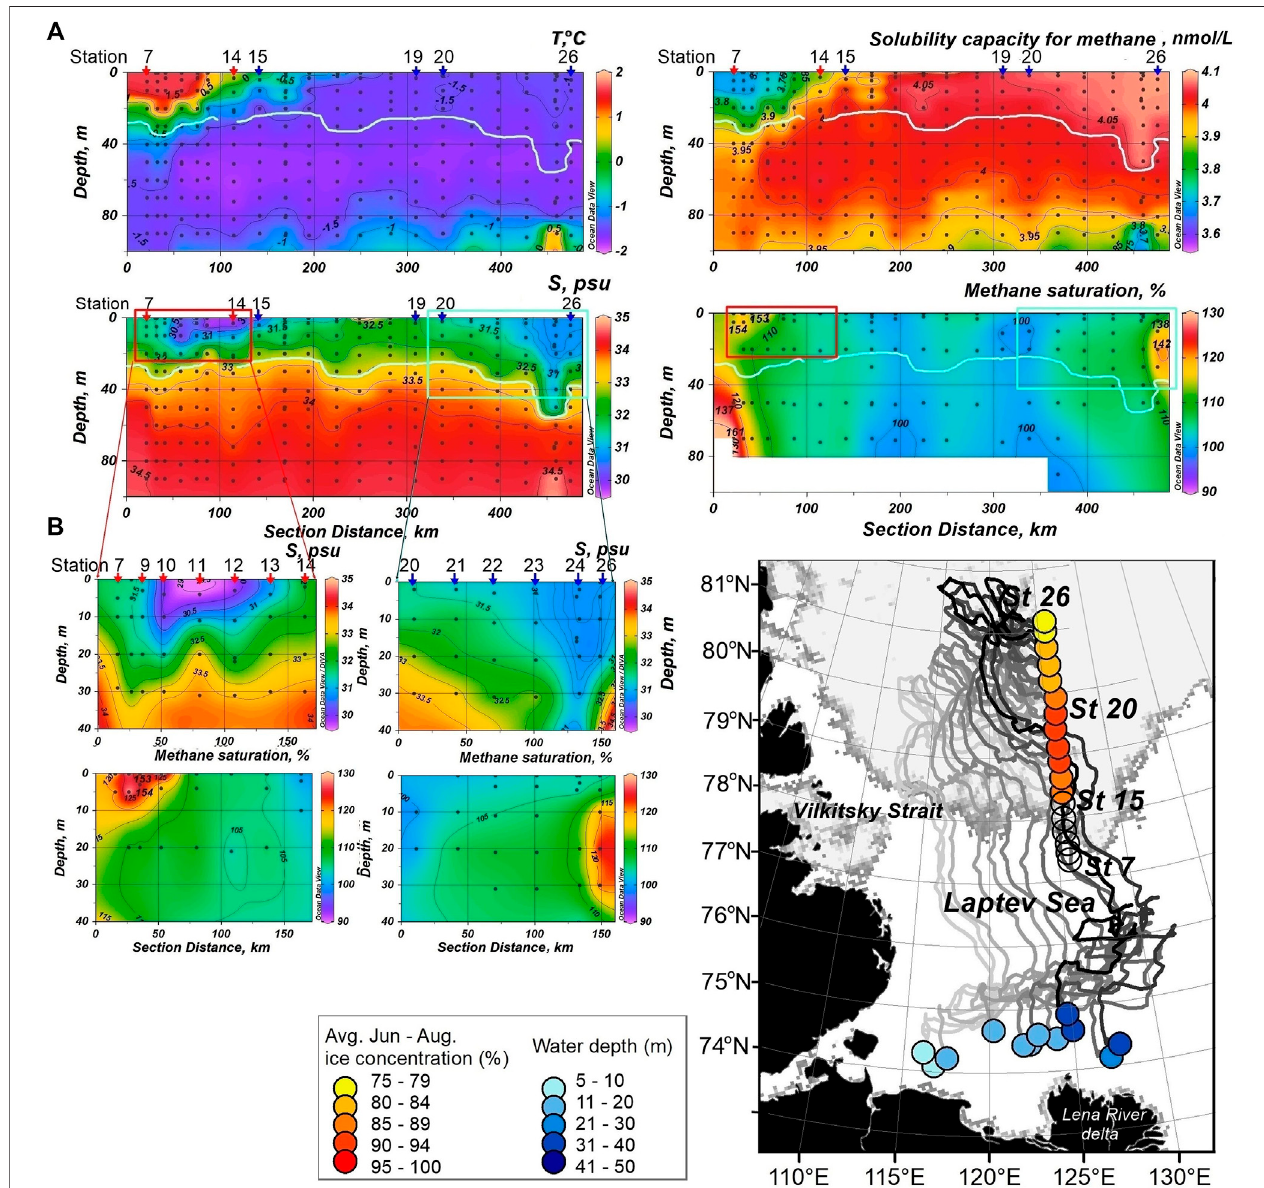
FIGURE 4 | (A) Pro fi les of temperature, salinity, CH 4 solubility capacity (SC) and saturation along section A (126 o E, from south to north). During sampling, stations 7 – 14and 15 – 26 were ice-free[redarrows (A) , empty circles (B) ] and ice covered [blue arrows (A) , fi lled circles (B) ],respectively. Red and blue squarescontour theCH 4 plumes at the southern and northern stations, respectively. Extensions of the red and blue squares are given on the left of the lower panel. The white line gives the boundary between PML and CHL. (B) Backward trajectories of sampled sea ice obtained from IceTrack. The color of the end notes provide the corresponding water depths at the formation site. The color of the start nodes provides the June-August ice concentration, averaged along the individual track